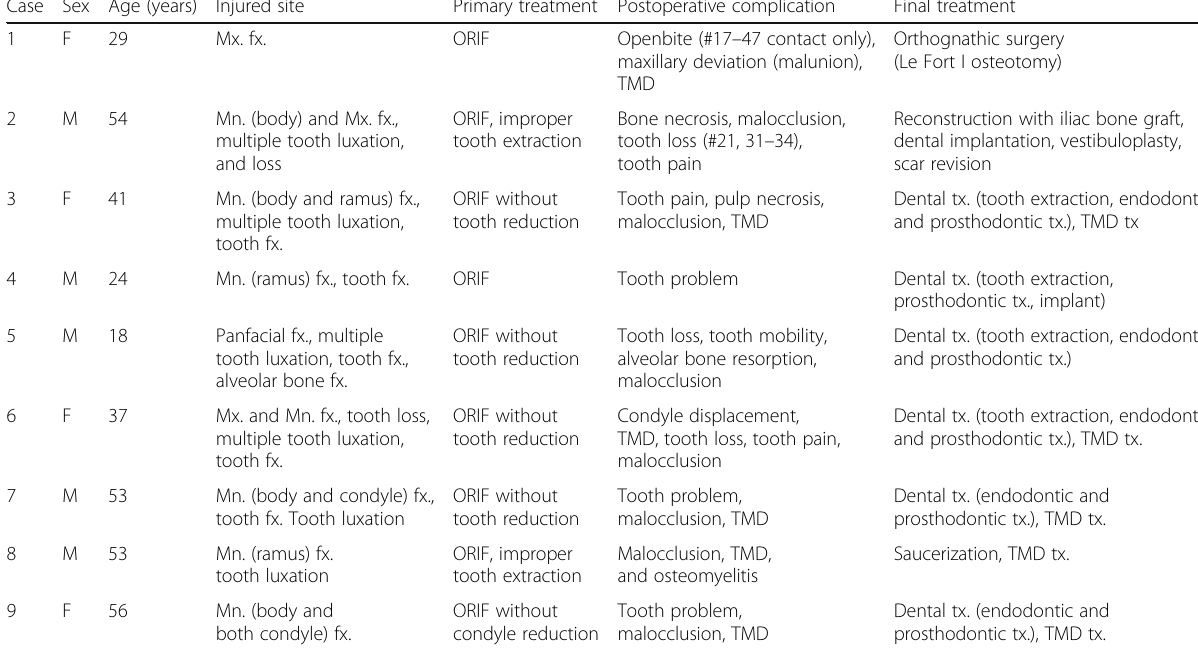
Table 1 Patients ’ information Case Sex Age (years) Injured site Primary treatment Postoperative